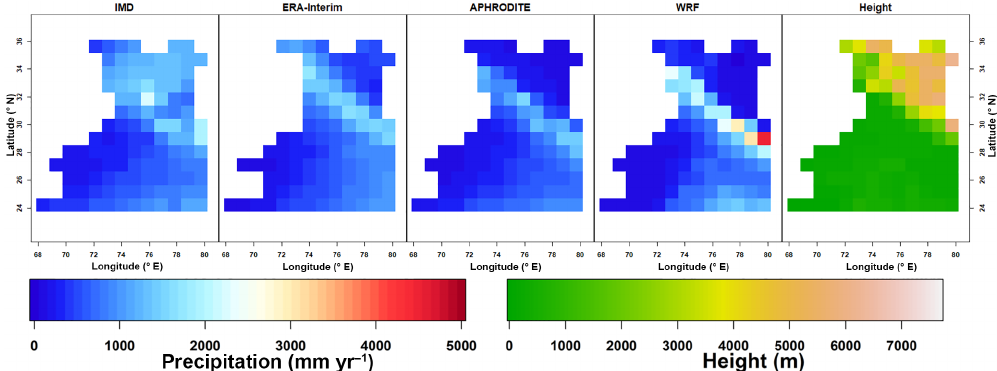
Figure A1. Precipitation of the gridded datasets and terrain height of the study area resampled to the IMD grid by bilinear interpolation.